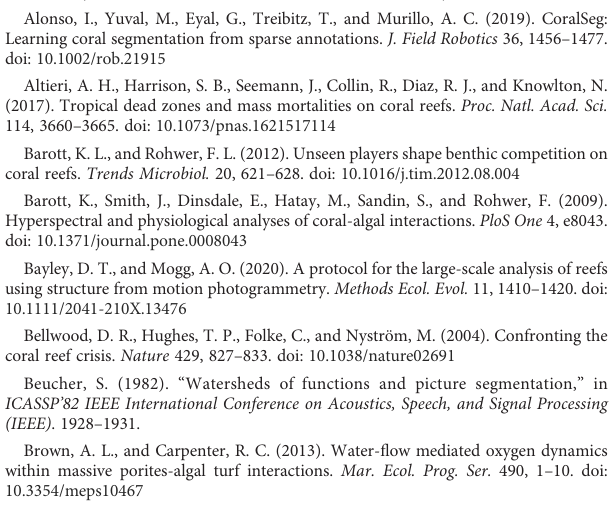
SUPPLEMENTARY FIGURE 2 Three-dimensional oxygen distribution patterns under forced- fl ow conditions during day and night time. The oxygen legend refers to the oxygen concentration at the seabed, overlaid with volumetric isocontours in the body of water above: a yellow isocontour at 180 µmolL − 1 and light blue one at 205 µmolL − 1 (matching the legend coloring). As well as the low- oxygenzoneappearingintherecirculationeddyfollowingtheraisedoutcrop, there are also plumes of oxygen seen. An animated version of the full day- night cycle can be seen in Video S4 provided in the Supplementary materials accompanying this manuscript. SUPPLEMENTARY FIGURE 3 Zoomed-in regions of to indicate the level of complexity and small-scale features included in the simulation